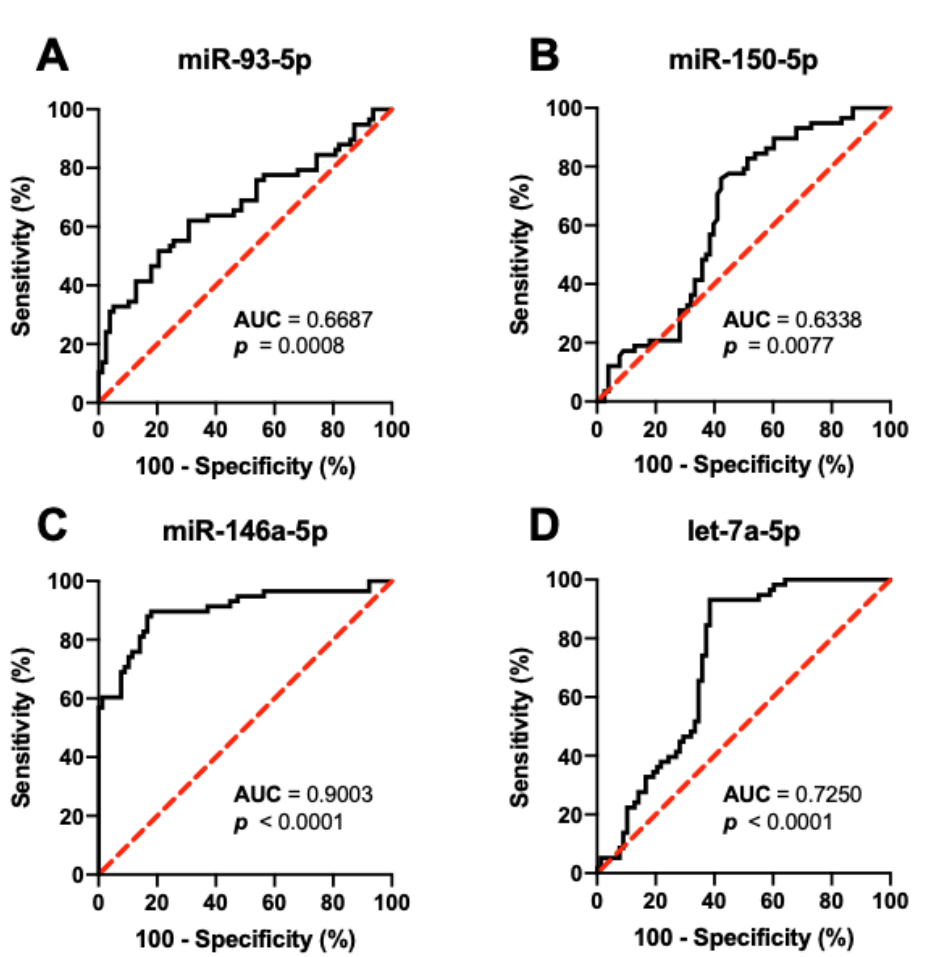
Figure 3. Differentiation of schistosomiasis-infected patients without ultrasonographic evidence of hepatic fibrosis (type 0) from those with hepatic fibrosis (types 1 – 3) by expression levels of circulat- ing serum ( A ) miR-93-50, ( B ) miR-150-5p, ( C ) miR-146a-5-, and ( D ) let-7a-5p at baseline using the ROC curve analysis. Note : p -values were computed using Wilson/Brown test.